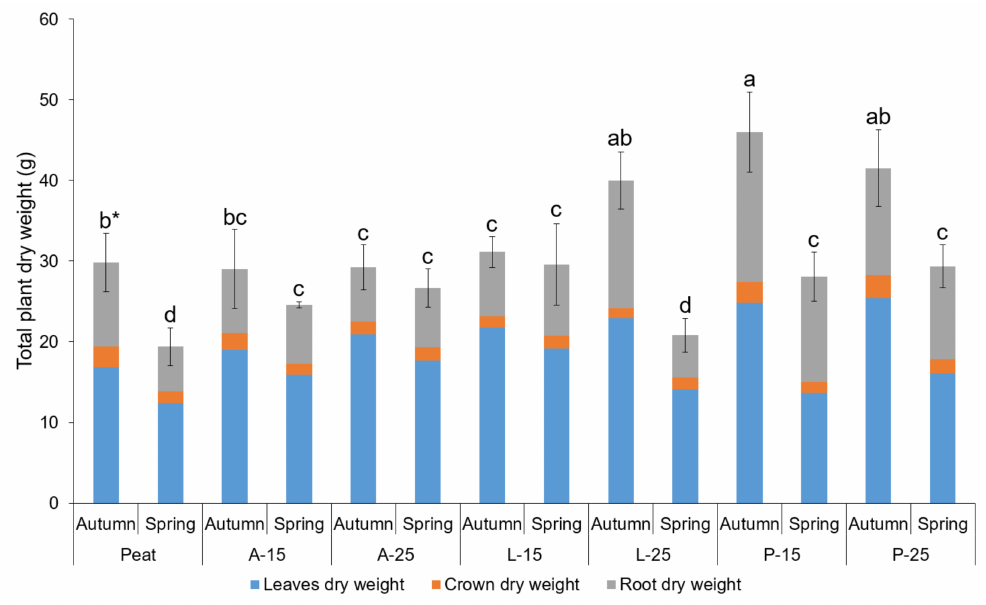
Figure 3. Total plant dry weight of strawberry plants as influenced by substrates and planting seasons. * means followed by the same letters are not significantly different at p < 0.05 according to Tukey’s HSD ( n =